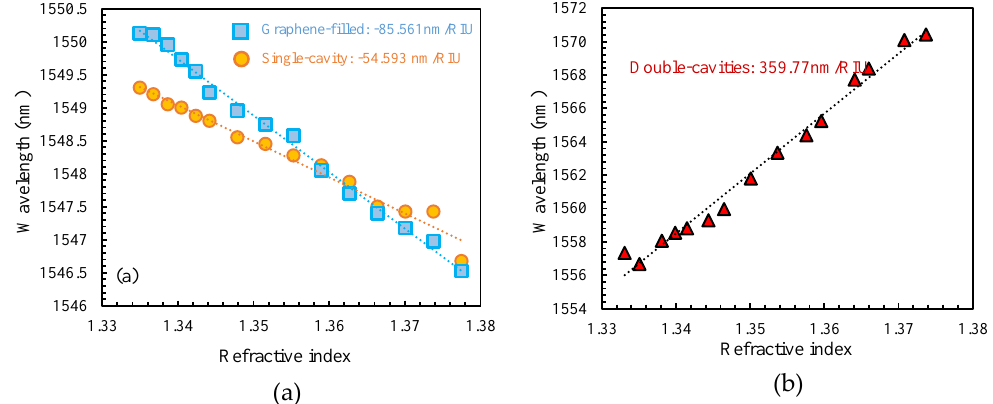
Figure 8. Linear fitting curves between dip wavelength and solution RI of ( a ) single-cavity and graphene-filled single-cavity sensor, and ( b ) double-cavities sensor, respectively.